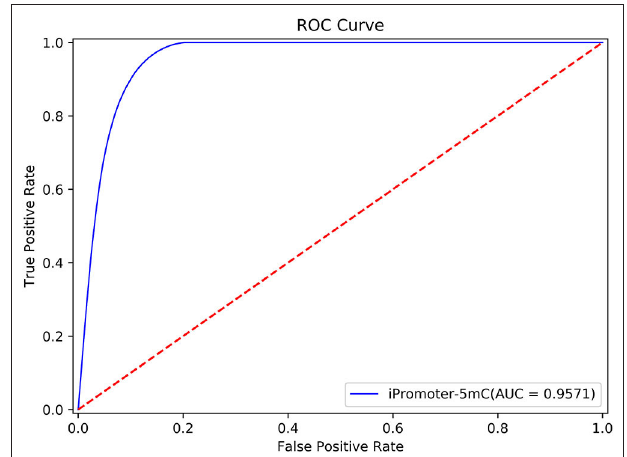
FIGURE 6 | The performance generated by the same prediction framework was still reliable and stable after the expansion of the training data.